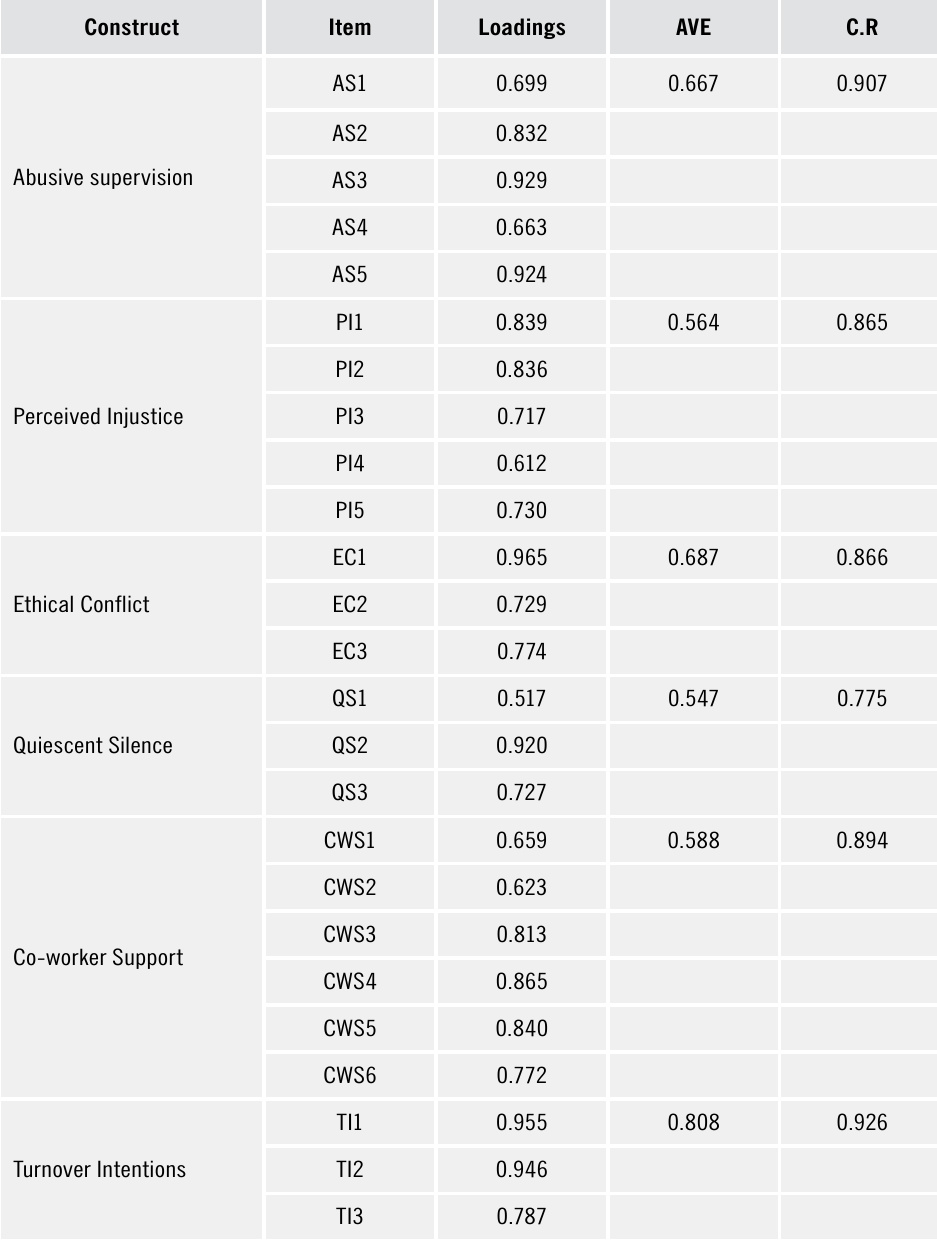
Table 3. Measurement